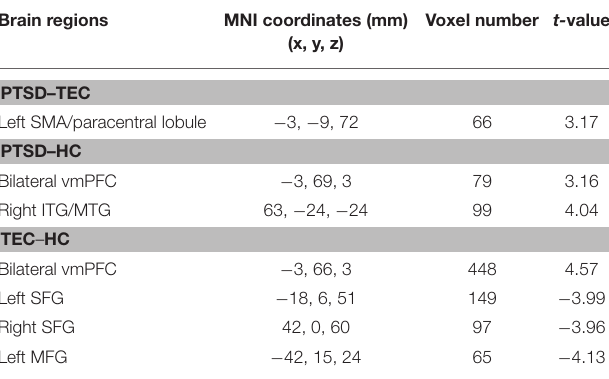
TABLE 2 | Comparison of effective connectivity from the